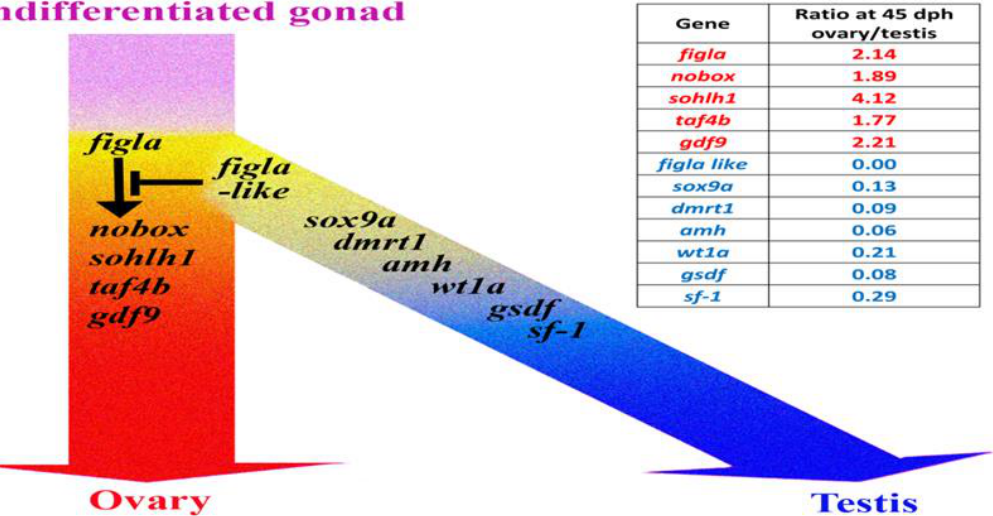
Figure 3. Proposed model of the sex related genes’ expression during LG1-driven gonad differen- tiation. On the right, the table shows the observed ratio between the RPKM values of these genes calculated for As at 45 days posthatch (Table S4). With increased expression in the ovary (red), Figla upregulates a subset of transcripts orthologous to mouse germline genes ( nobox , sohlh1 , taf4b , and gdf9 ) and their downstream genes, which are essential for early oocyte development [83]. Increased expression in the testis (blue) of a subset of known testis genes ( figla-like , sox9a , dmrt1 , amh , wt1a , gsdf , and sf-1 ) [84] is compatible with diverting the default female into the male developmental program.